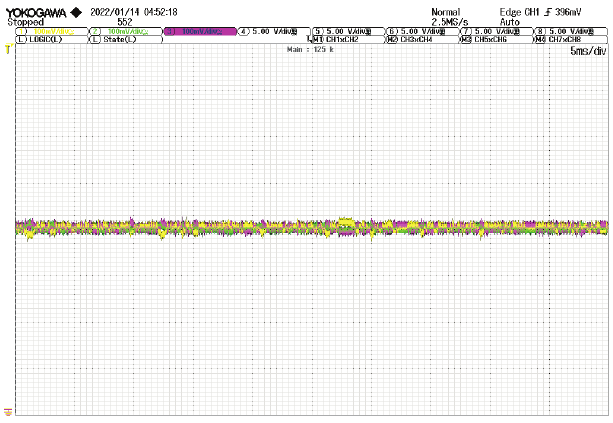
Figure 12. HIL results for the three dc-link capacitor